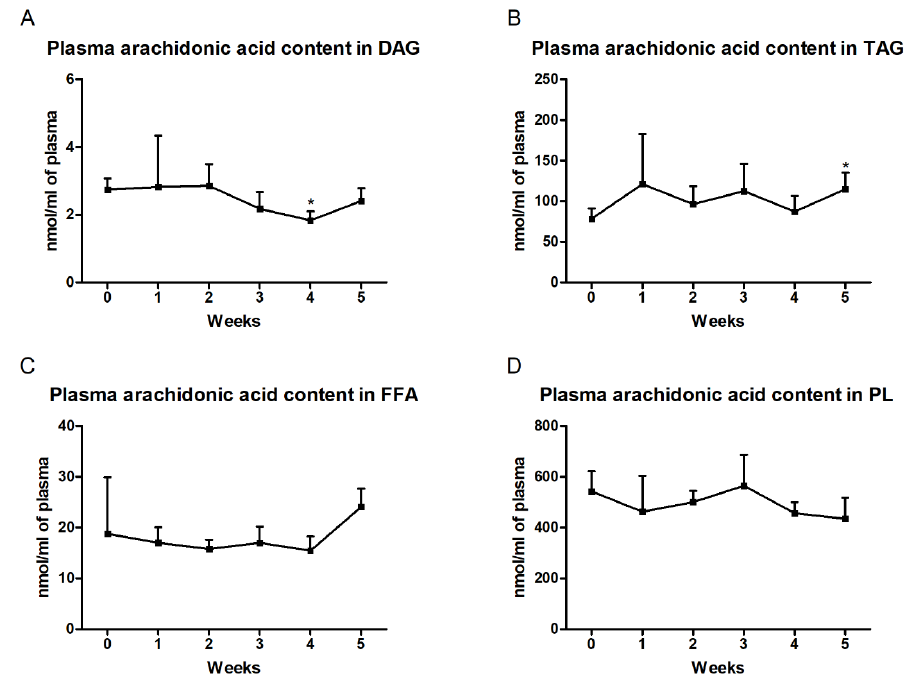
Figure 3. Plasma contents of arachidonic acid in the ( A ) diacylglycerol (DAG), ( B ) triacylglycerol (TAG), ( C ) free fatty acid (FFA) and ( D ) phospholipid (PL) fractions. Changes in the arachidonic acid content in the selected lipid fractions were examined by the gas–liquid chromatography (GLC) method. The data are expressed as mean ± SD and are based on six independent determinations. * p < 0.05, significant difference compared with the control group (0 week).